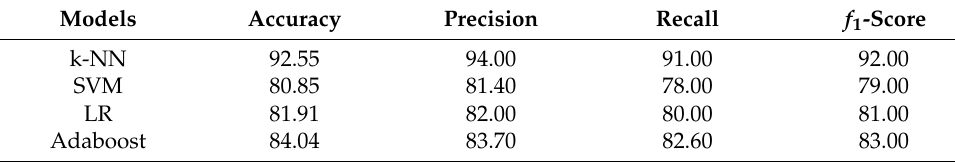
Table 1. Results for single validation of the